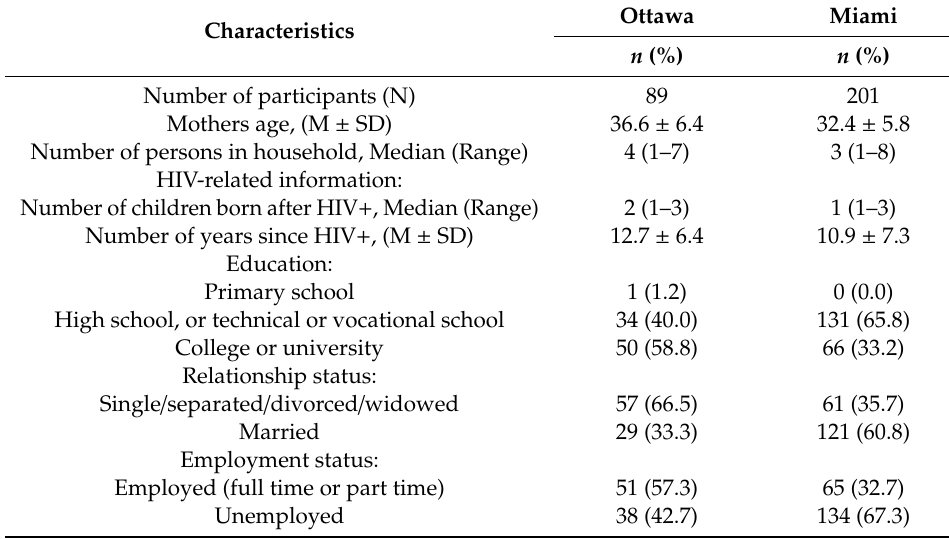
Table 1. Socio-demographic